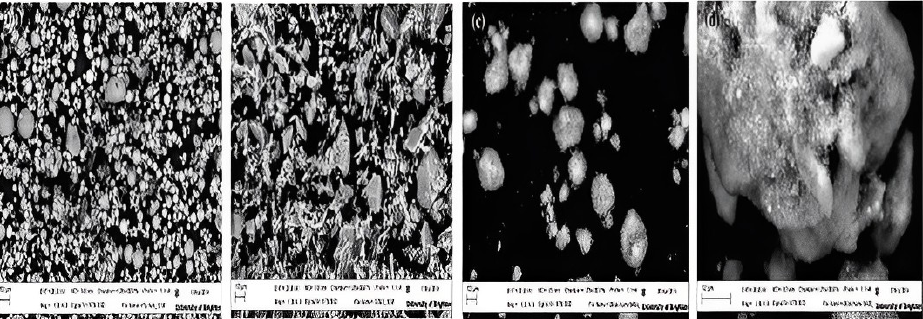
Figure 16. SEM images of ( a ) Fly ash, ( b ) slag, ( c ) USF, and ( d ) DSF [106]. (Reprinted with permis- from the publisher, Elsevier; License No.